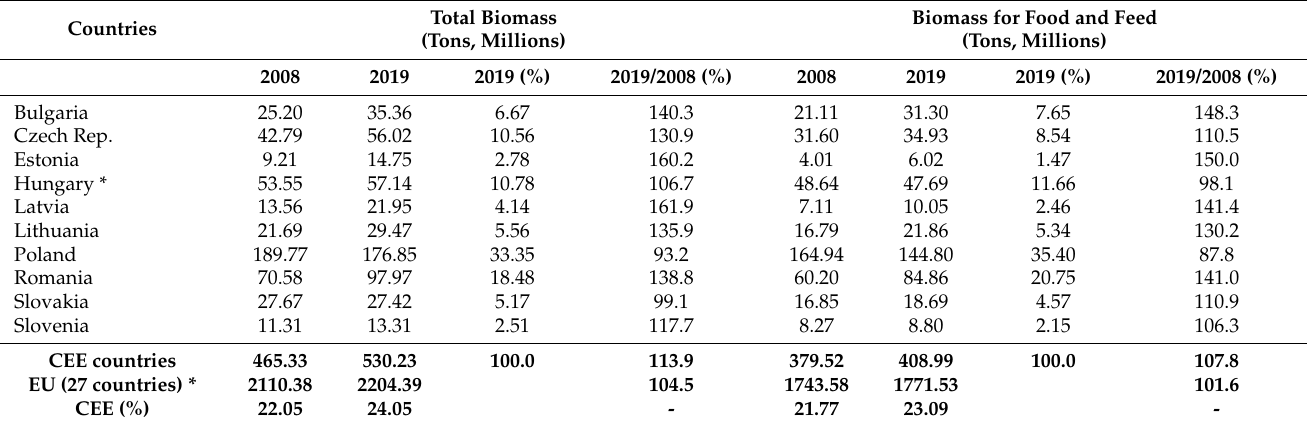
Table 7. Direct material input of biomass for use in economy and direct material input of biomass for food and feed.